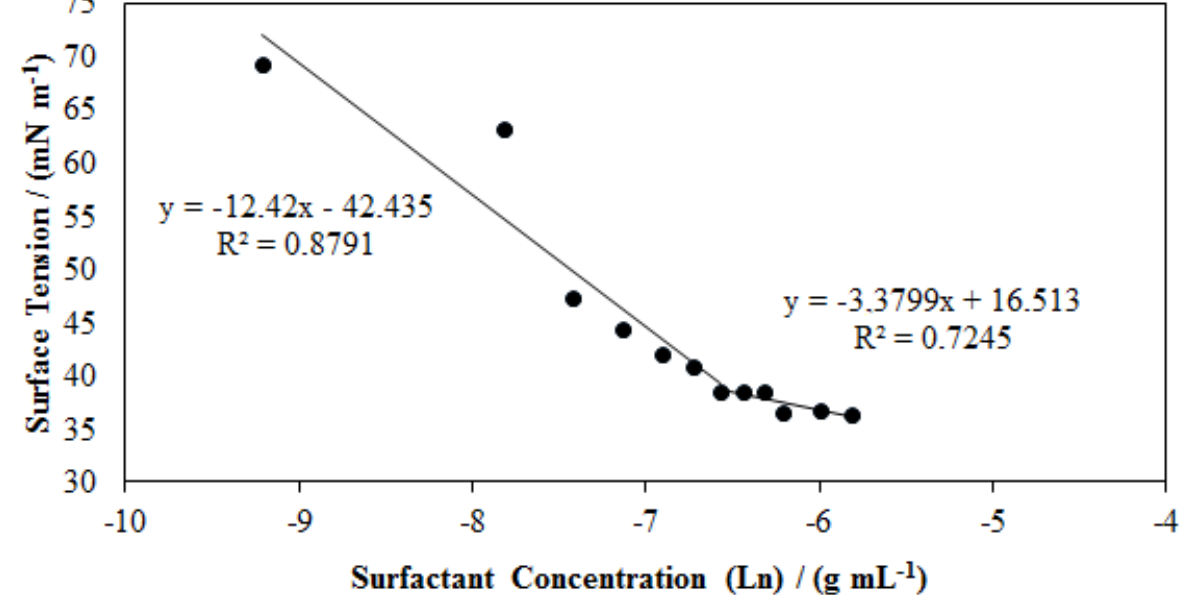
Figure 1. Variation of surface tension as a function of ln C for anionic surfactant SCO, at 27